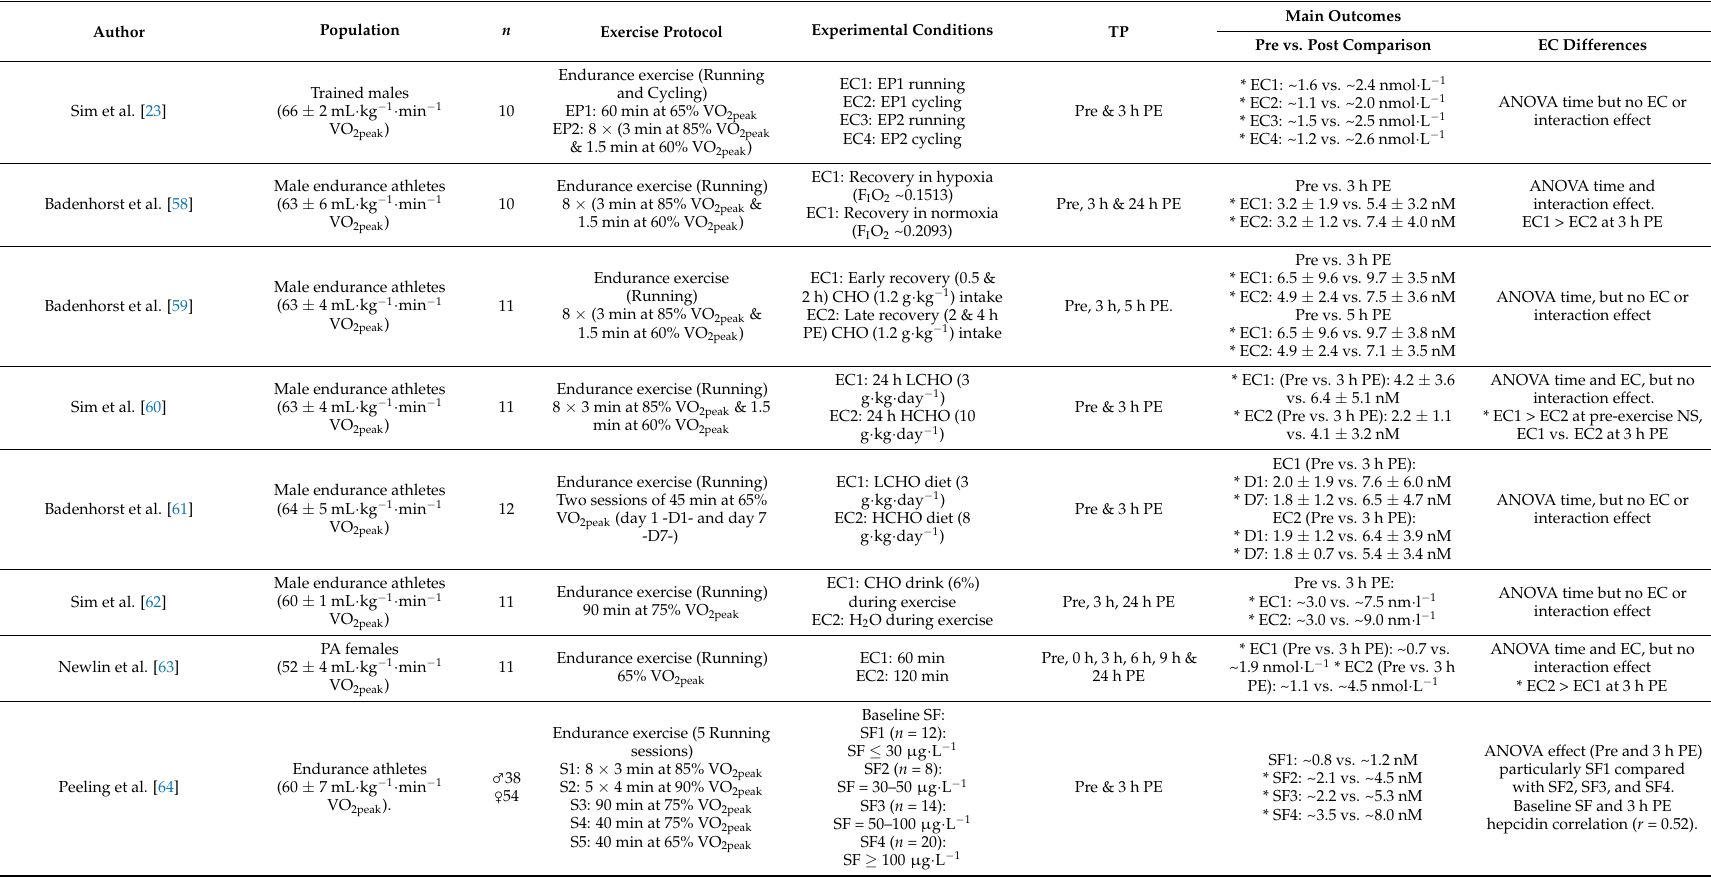
Table 1. Summary of the studies investigating the effect of a single session of exercise on serum hepcidin